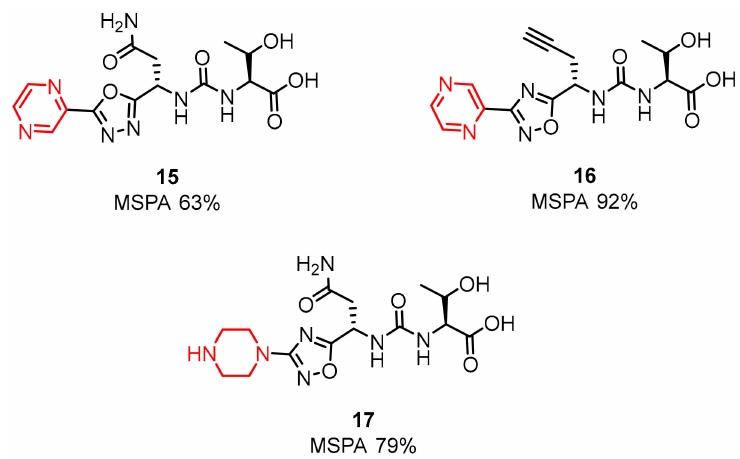
Figure 9. Modifications of structures 13 and 14 [55,56].